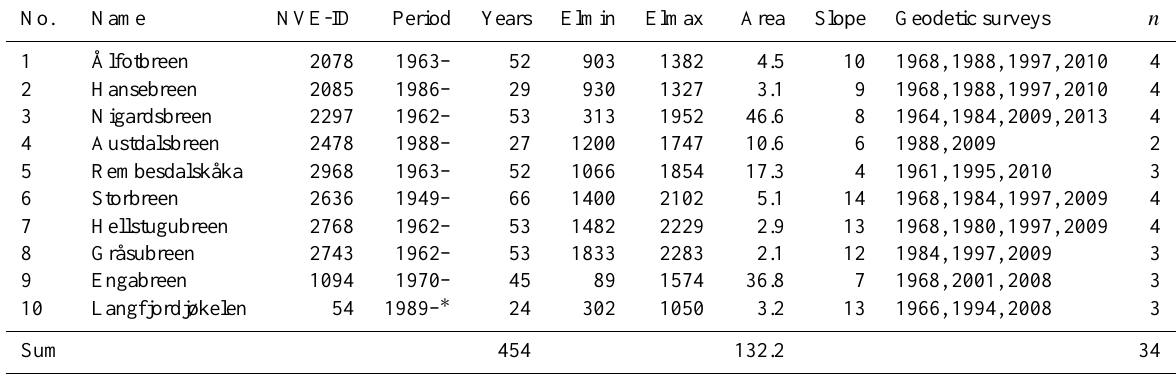
Table 1. Overview of the 10 glaciers used in this study, their characteristics, and glaciological and geodetic surveys used in this study. Period is period of mass-balance observations; years is number of mass-balance years up to and including 2014. Elevation minimum and maximum (ma.s.l.), slope (degree), and area (km 2 ) refer to the latest survey. NVE-ID is the ID in the latest inventory (Andreassen et al., 2012b). See Fig. 1 for location and Table 2 for details on geodetic surveys.